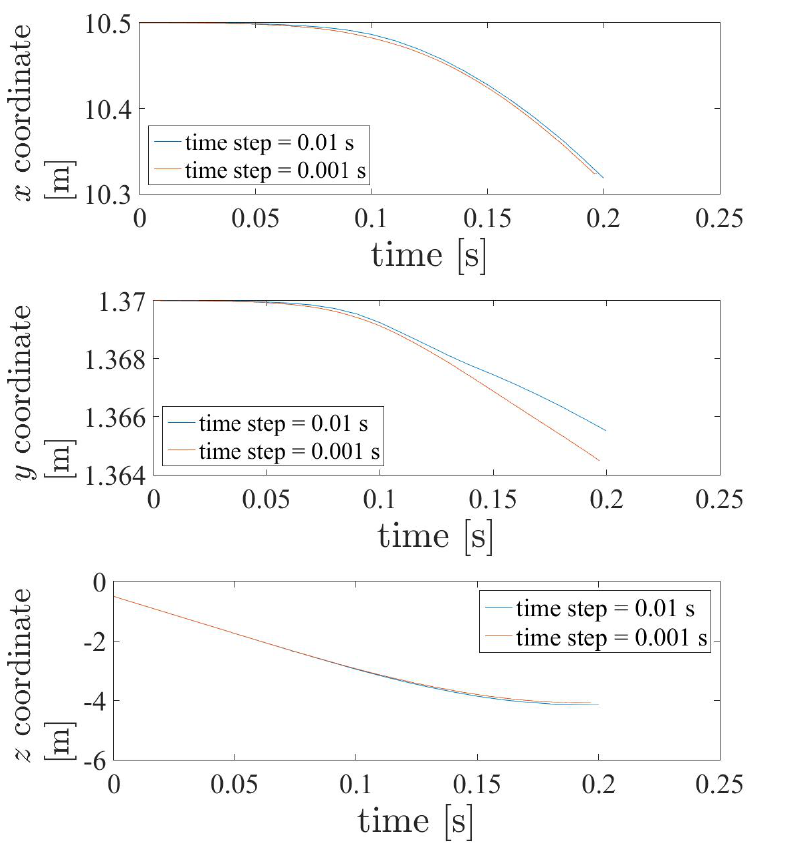
Figure 9. Position in the x , y and z directions as a function of time for dt = 0.01 s and dt = 0.001 s.